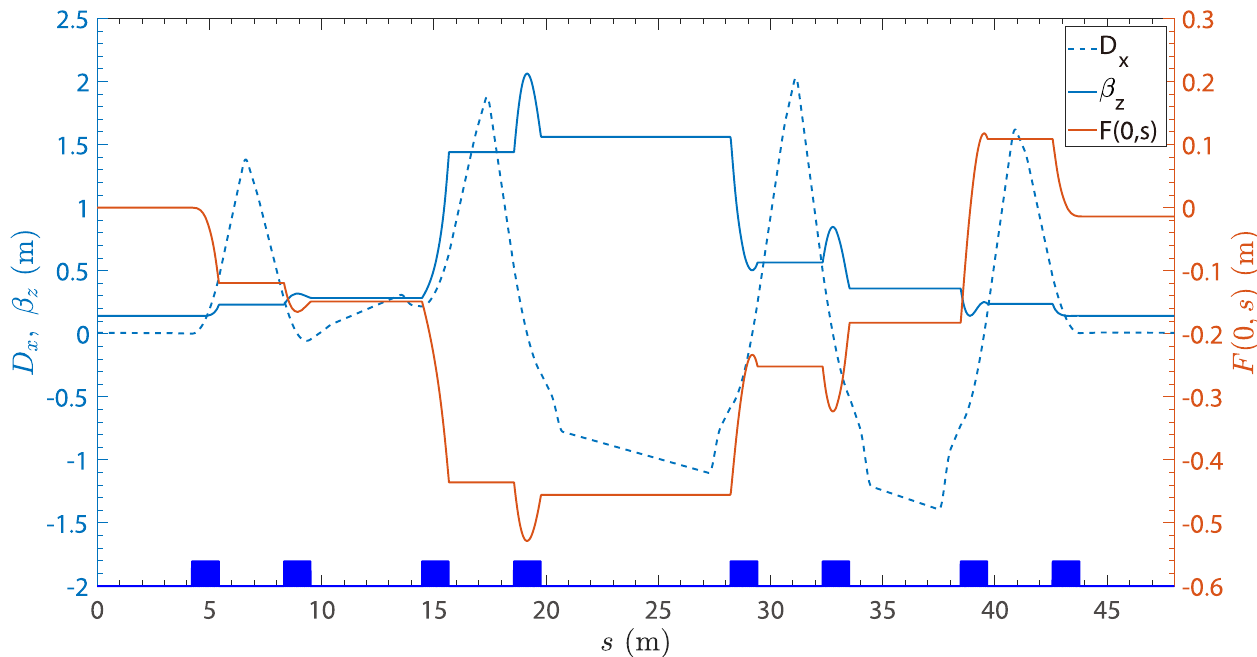
FIG. 1. The horizontal dispersion D x , longitudinal beta function β z , and F ð 0 ; s Þ of the MLS lattice used for analysis and simulation. In ¼ 0 m and V ¼ 80 MV is applied. The dipoles are shown at the bottom as blue rectangles. this plot, the zero-length rf is placed at s rf rf Each dipole has a length of 1.2 m and bends the electron trajectory for an angle of π = 4